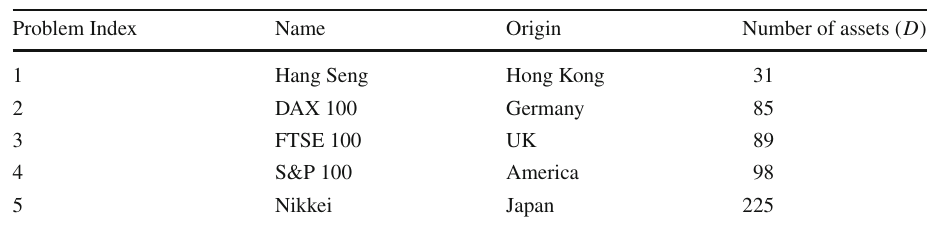
Table 7 Information of the portfolio optimization problems